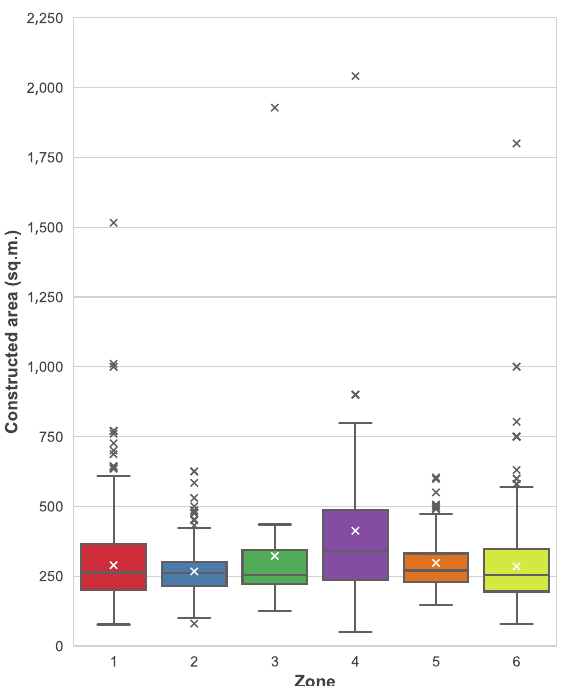
Figure 6. Boxplot of the distribution of constructed areas based on the asset location.